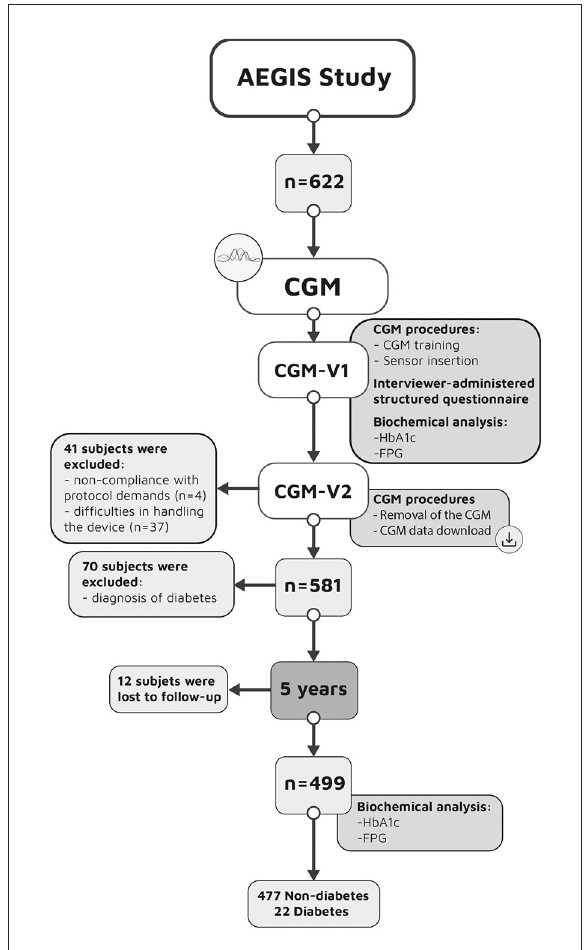
FIGURE1 Study procedures. CGM, continuous glucose monitoring; V, visit; HbA1c, glycosylated hemoglobin; FPG, fasting plasma glucose.